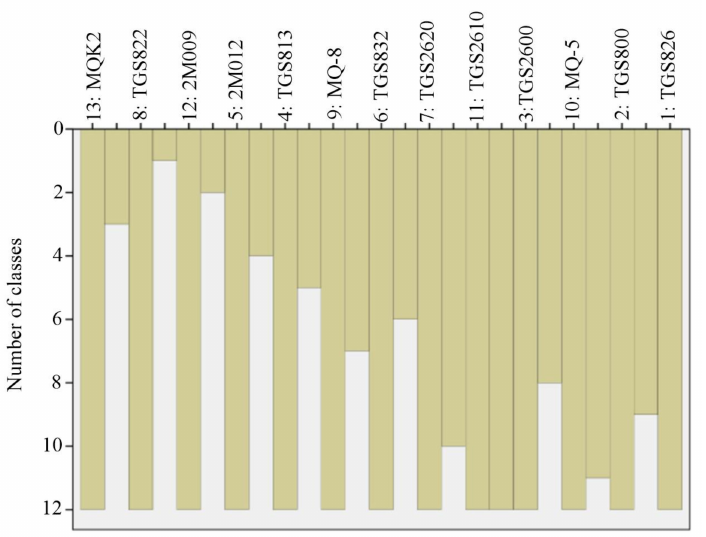
Figure 9. Icicle figure of clustering sensors’ response average value (3 kinds of baked green